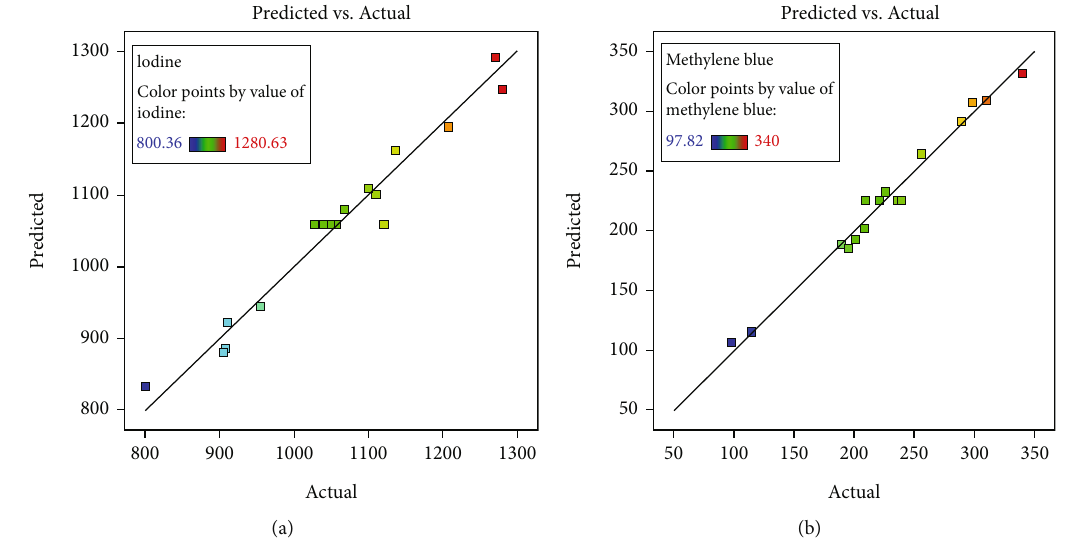
Figure 3: Actual vs. predicted plots of (a) iodine number and (b) methylene